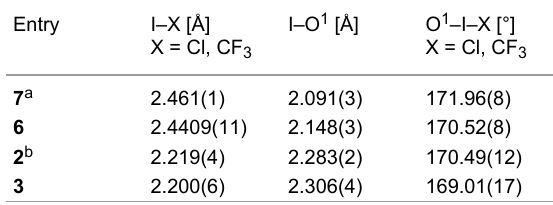
Table 1: Selected bond lengths and angles for compounds 2 , 3 , 6 , 7